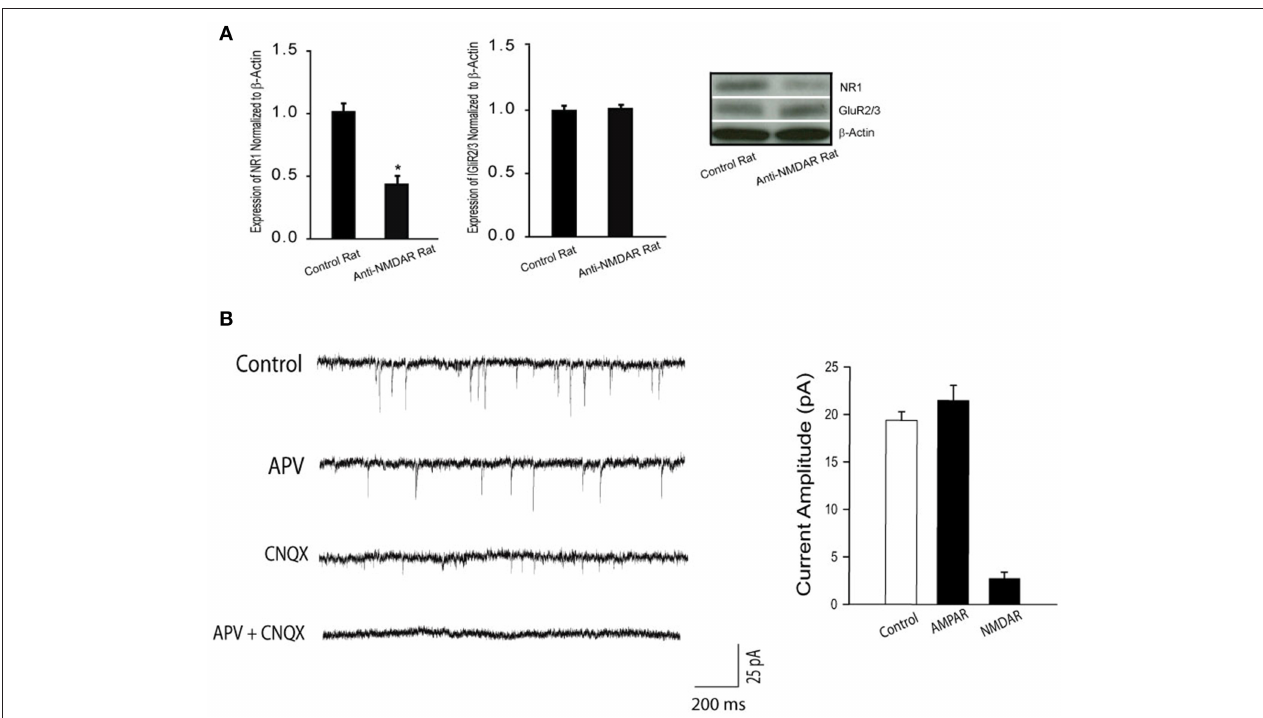
FIGURE 1 | (A) Protein expression NR1 and GluR2/3 in the hippocampus of control rats and rats treated with anti-NMDAR. Treatment of anti-NMDAR attenuated the protein levels of NMDA NR1 but not AMPA GluR2/3. * P < 0.05 vs. control rats. The number of rats = 6 in each group. (B) Typical traces and averaged data, showing NMDAR- and AMPAR-mediated mEPSCs. The mEPSCs were recorded in perfusion solution with TTX, picrotoxin, and 0 Mg 2 + to isolate synaptic glutamate-mediated currents. APV, an NMDA receptor antagonist, blocks mEPSCs, allowing AMPAR-mediated currents observed. CNQX, an AMPA receptor antagonist, blocks mEPSCs, allowing NMDAR-mediated currents observed. As APV plus CNQX were applied, mEPSCs were completely blocked. Twelve neurons were used in this experiment. Under the same recording conditions, NMDAR-mediated mEPSCs were examined in the hippocampal neurons of control rats and rats with anti-NMDAR that were presented in Figure 2